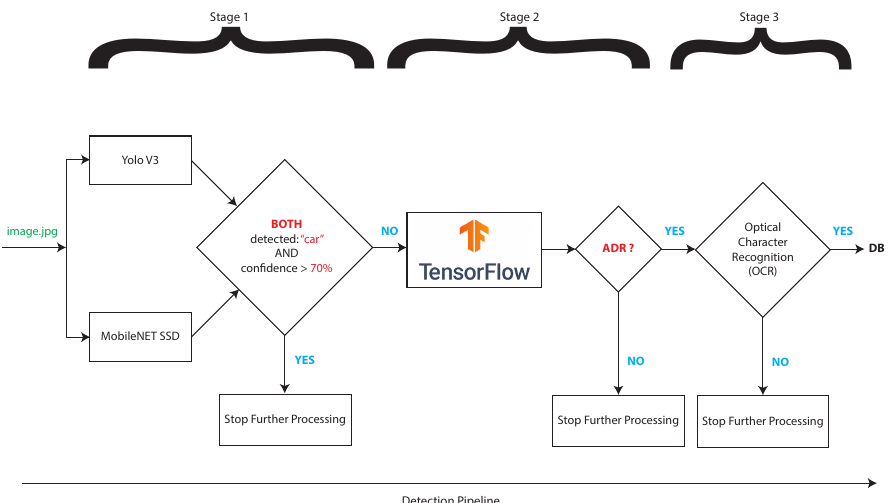
Figure 1. Detection pipeline of the proposed ADR-Detection algorithm. Stage 1: Detection of large vehicles (heavy or truck). In this stage, two pre-trained Convo- lutional Neural Networks (CNN) are used, and if the detection is positive for a truck by both algorithms, stage 2 is executed. Stage 2: Detection of ADR contours. In this stage, ADR Regions of Interest (ADR-ROIs) are detected and stored in a special folder. It is achieved using a trained Faster-RCNN that includes a single ADR class at its final classification